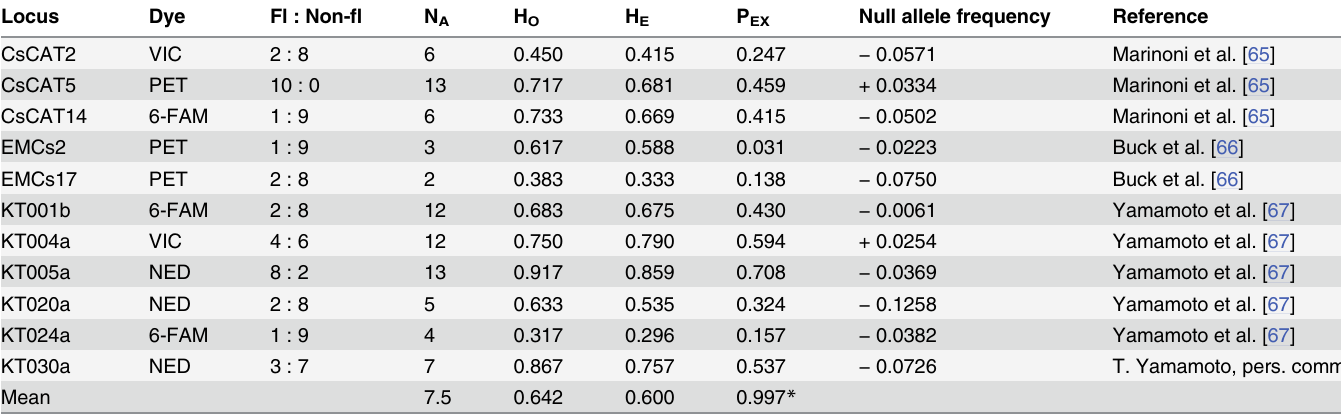
Table 2. Characteristics of the microsatellite loci, including the type of fluorescent dye (Dye) and the mixing ratio of fluorescent and non-fluores- cent forward primers (Fl: Non-fl), the observed number of alleles ( N A ), observed ( H O ) and expected ( H E ) heterozygosity, probability of exclusion when one parent is known ( P EX ), and estimated null allele frequency by locus for the 60 individual Castanea crenata trees at the Field Research Center, Tohoku University, Miyagi,